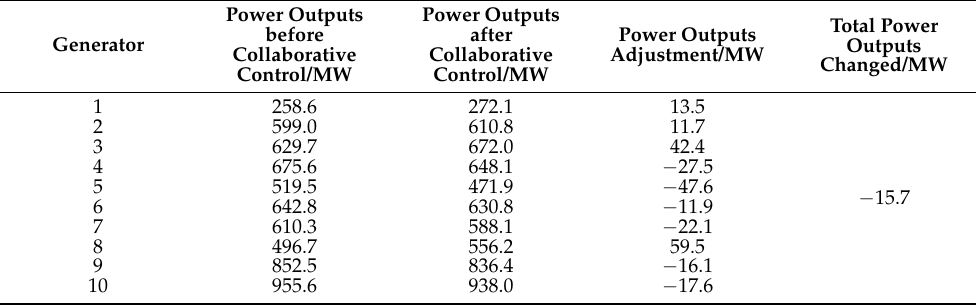
Table 5. Comparison of generators’ active power outputs before and after collaborative transient stability control of IEEE 39 bus system.